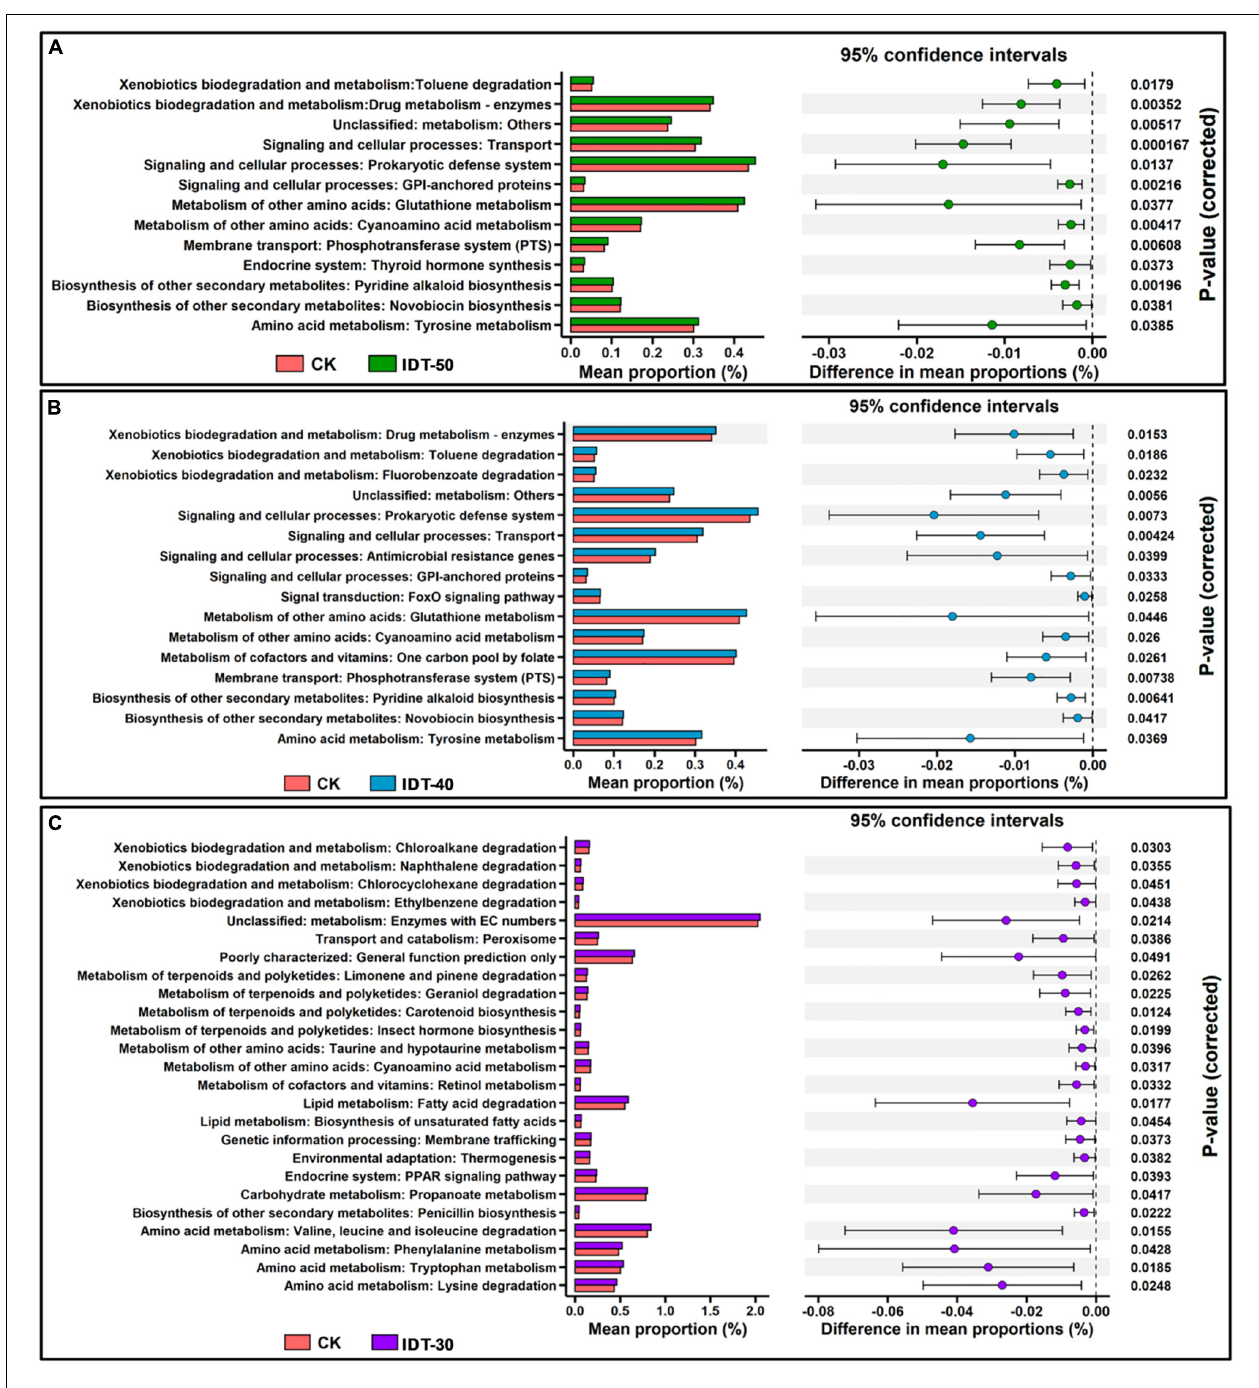
FIGURE 6 | PICRUSt predicted metagenome functions at level 3. (A) Post hoc plot showing KEGG level 3 function terms that differed significantly between IDT-50 and CK. (B) Post hoc plot showing KEGG level 3 function terms that differed significantly between IDT-40 and CK. (C) Post hoc plot showing KEGG level 3 function terms that differed significantly between IDT-30 and